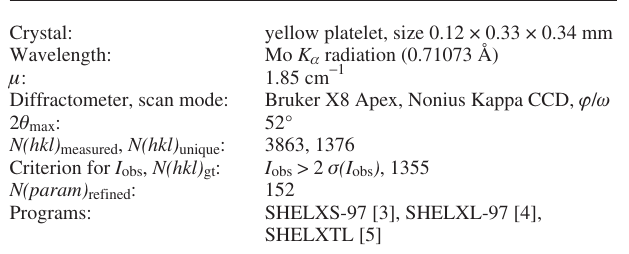
Table 1. Data collection and handling.